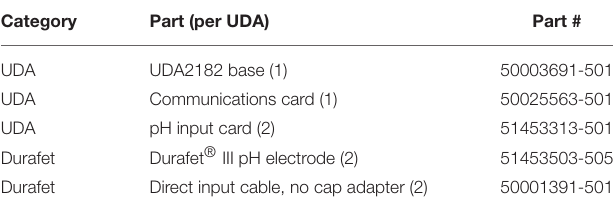
TABLE 1 | Components for the Honeywell UDA-Durafet